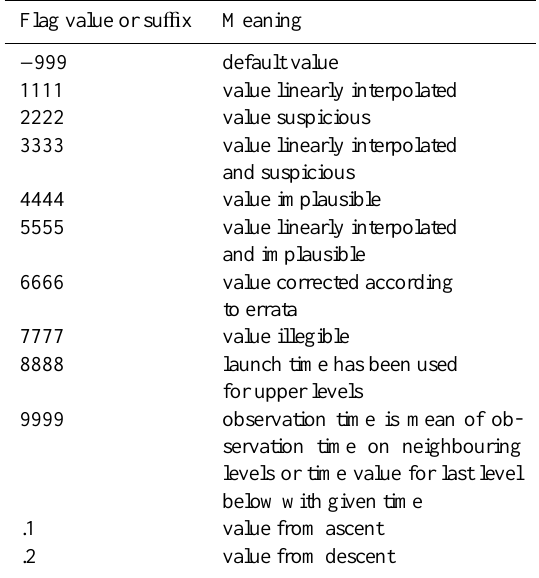
Table 9. Meaning of flag values used in the upper-air data files. Table 10. Numbers used to specify observational platform (“data type”) in the upper-air data